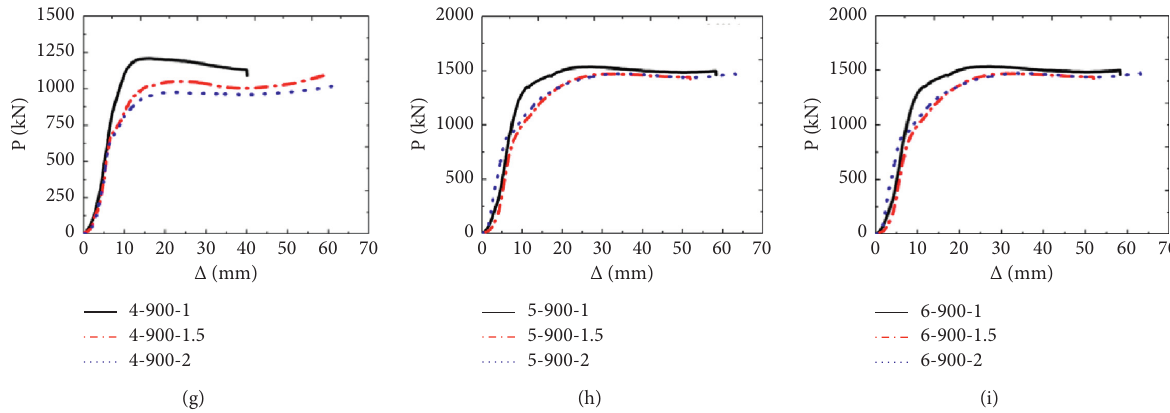
Figure 15: Different durations for the same wall thickness and the same temperature. (a) 4 mm thickness with 300 ° C temperature. (b) 5mm thickness with 300 ° C temperature. (c) 6mm thickness with 300 ° C temperature. (d) 4mm thickness with 600 ° C temperature. (e) 5mm thickness with 600 ° C temperature. (f) 6mm thickness with 600 ° C temperature. (g) 4mm thickness with 900 ° C temperature. (h) 5mm thickness with 900 ° C temperature. (i) 6 mm thickness with 900 ° C